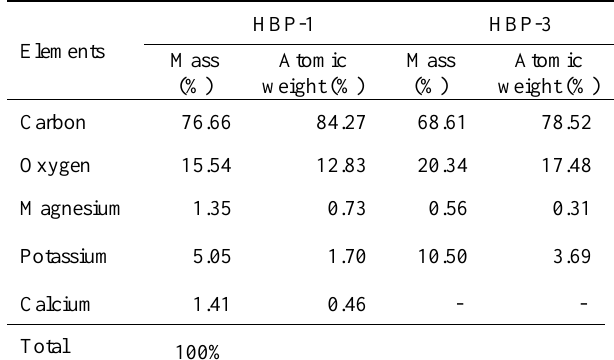
Table 4. Chemical composition analysis from EDX.